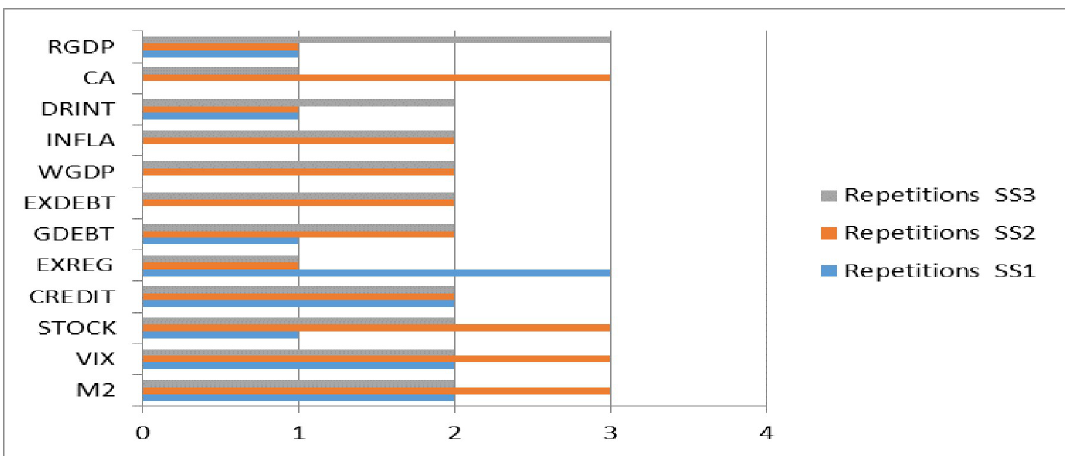
Fig 9. Number of repetitions of the greater sensitivity variables in SS1, SS2 and